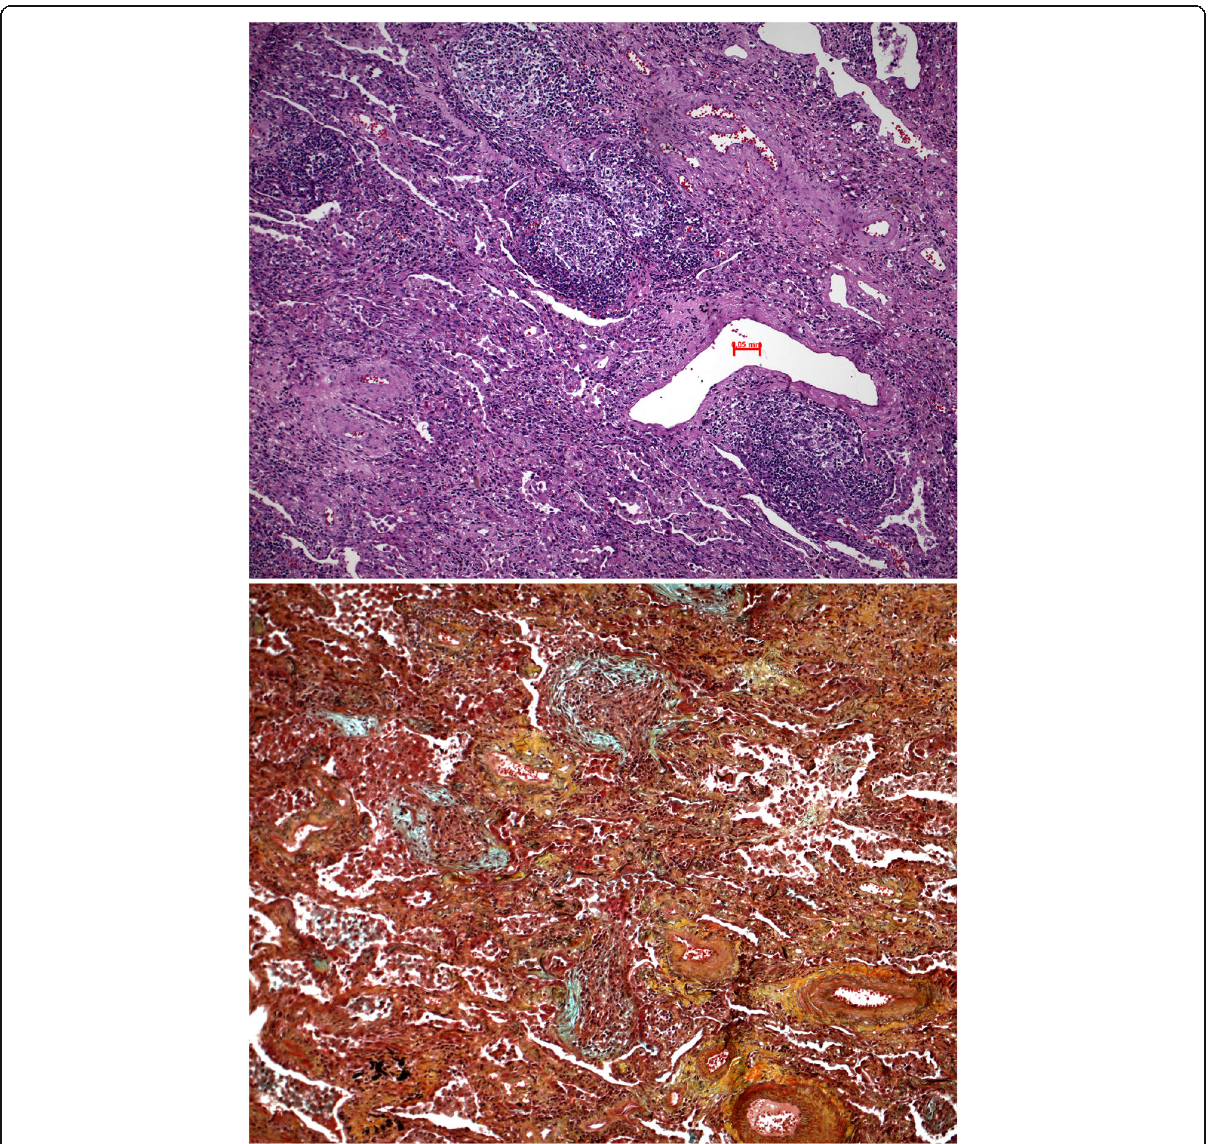
Fig. 19 Dermatomyositis, in this case the UIP pattern with myofibroblastic foci is not easily detected (upper panel), but these are highlighted by Movat stain (lower panel); there is fibrosis, cystic remodeling, but also BALT hyperplasia and sclerosis of pulmonary arteries. H&E and Movat stain, bars 50 μ